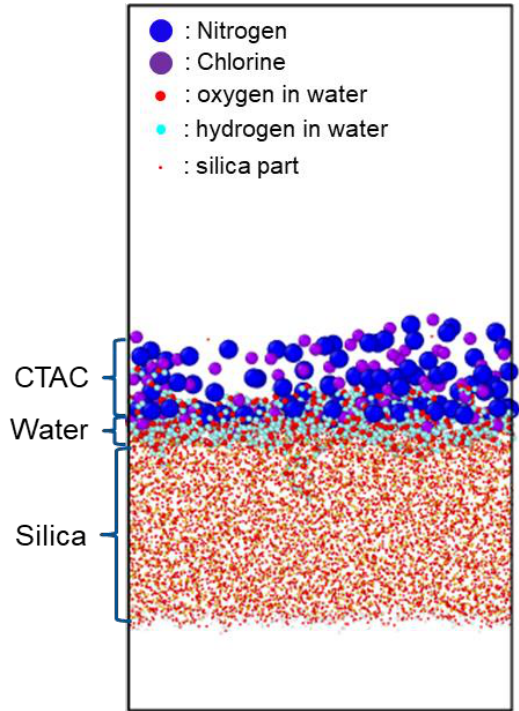
Figure 14. CTAC–silica interface in the presence of interfacial water layer. Tail groups of CTAC were omitted for clear visualization of the interface.